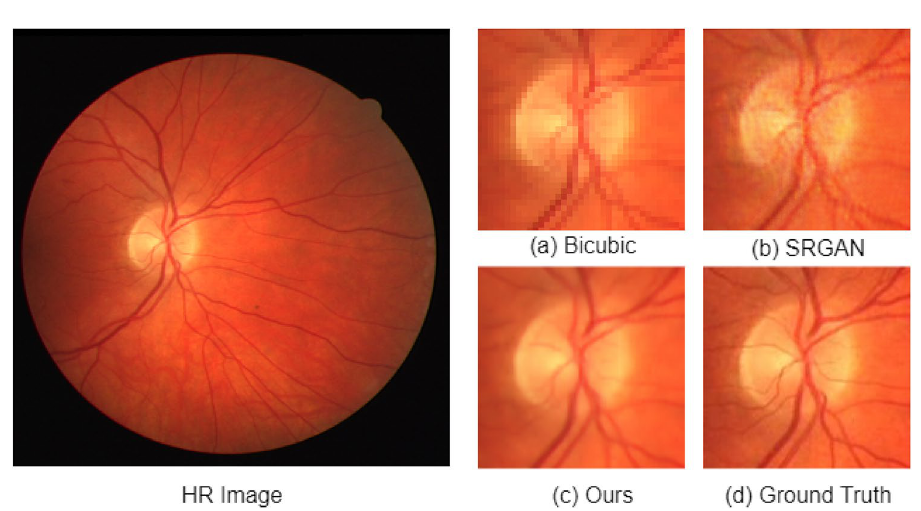
Figure 8. Small region results for an image from DRIVE dataset. The sub-region for ( a ) Bicubic interpolation. ( b ) SRGAN 31 . ( c ) Proposed architecture. ( d ) Ground truth HR